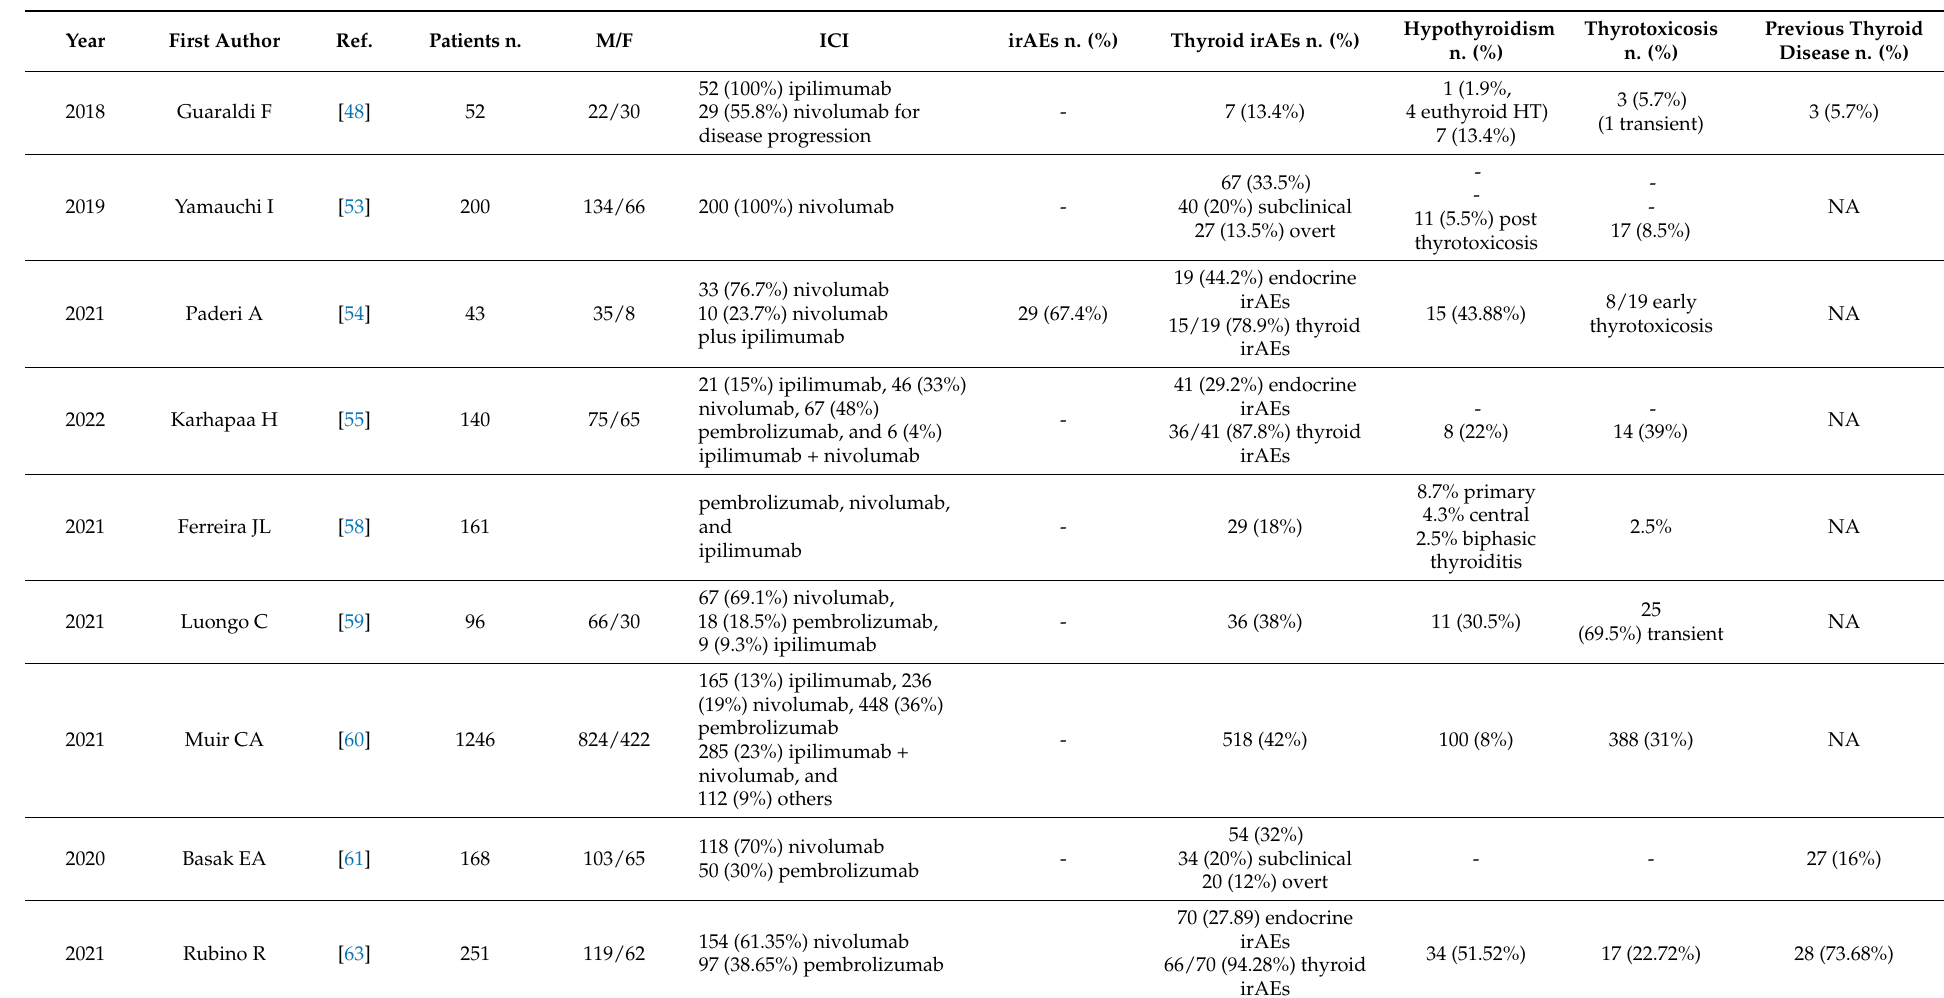
Table 2. An overview of the main studies reporting on thyroid irAEs from ICIs